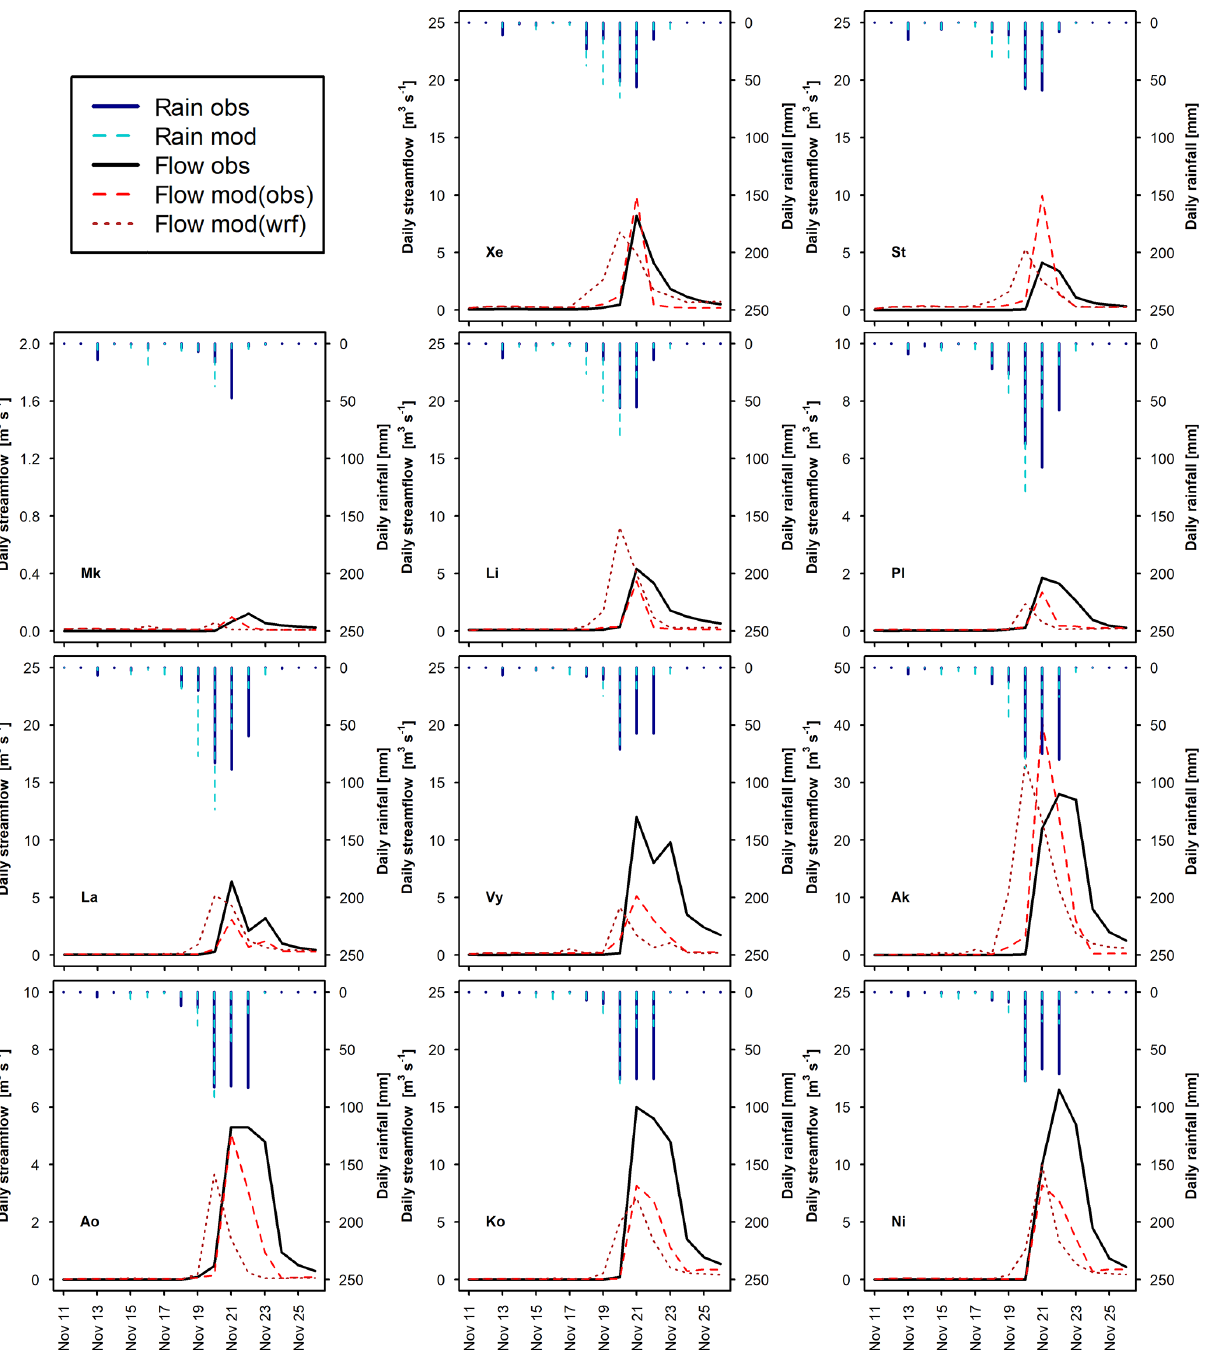
Figure 7. Observed daily hydrographs (Flow obs) and hydrographs obtained with the calibrated WRF-Hydro model (Flow mod) forced with observed rainfall (Rain obs) and with WRF-modelled rainfall (Rain wrf) for the November 1994 validation event, for 11 representative watersheds (see Table 1 for watershed